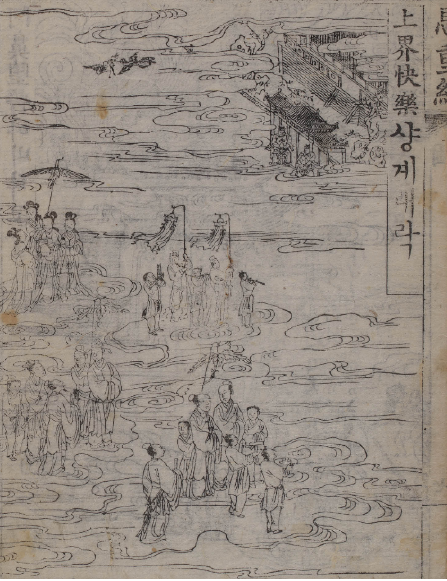
Figure 18. “Making one’s parents ascend to the heavenly realms and enjoy pleasure” from the vernacular Korean edition of the Sūtra on Deep Indebtedness to One ʼ s Father and Mother. Chosŏn, 1796. Woodblock printed on paper. 22.0 × 16.0 cm. Courtesy of Dongguk University Library.